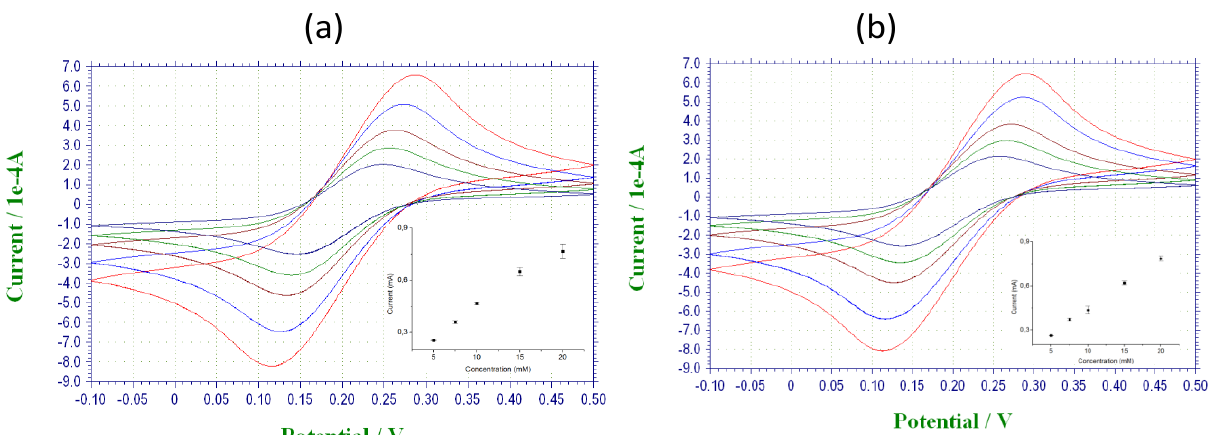
Figure 3. Cyclic voltammetry of carbon ( a ) and Ag/AgCl surfaces ( b ) in ferricyanide solutions (5, 7.5, 10, 15 and 20 mM in 0.1 M